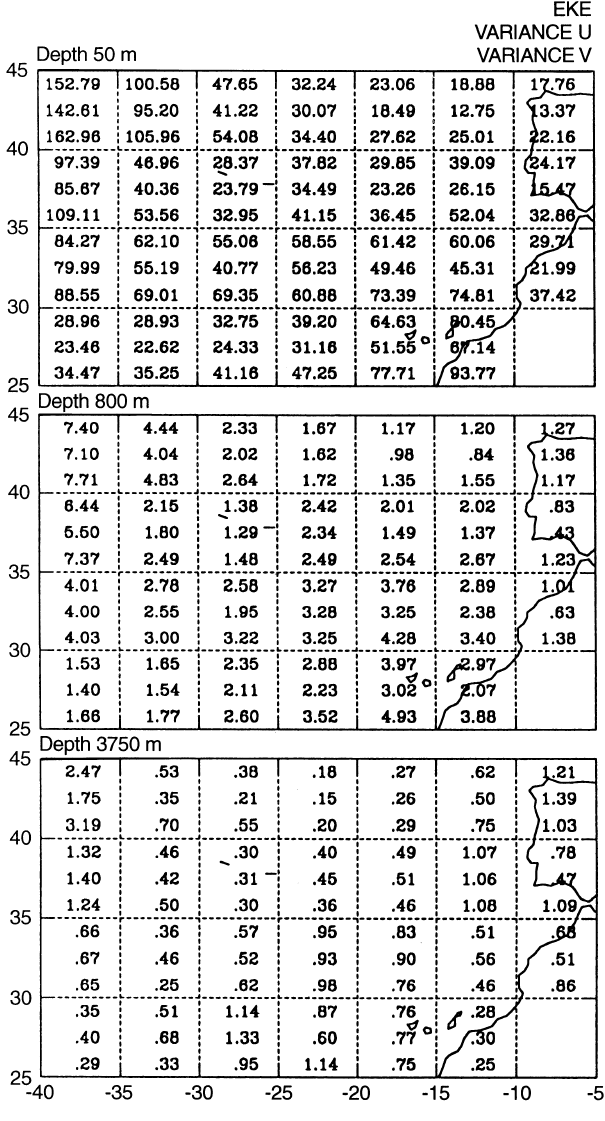
(cid:98) Fig. 14. Local averages over 5 (cid:176) (cid:180) 5 (cid:176) boxes of the eddy kinetic energy, the variance of U and the variance of V . Top at 50 m depth; middle at 800 m depth; bottom at 3750